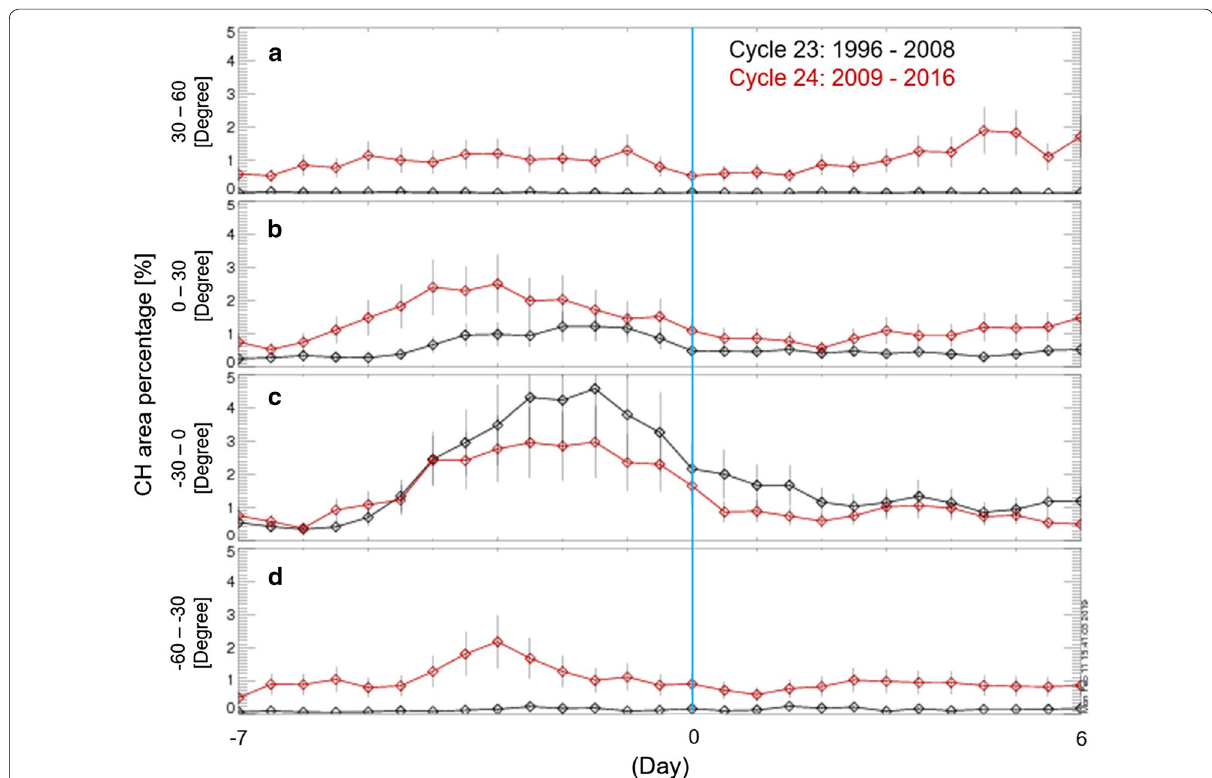
Fig. 6 Temporal variations of 12-h average CH area in the four latitudinal ranges for 13 days. The black and red lines correspond to the CH areas of solar cycle 23 (1996–2008) and 24 (2009–2016), respectively. The vertical light blue line represents the start time of an enhancement of solar wind velocity around the Earth’s orbit. The left labels “Area a,” “Area b,” “Area c,” and “Area d” in each panel show the regions of (30–60, 30 to 30), ( 30 to 0, 30 to 30), and ( 60 to 30, 30 to 30) degrees in the solar latitude and longitude, − − − − −